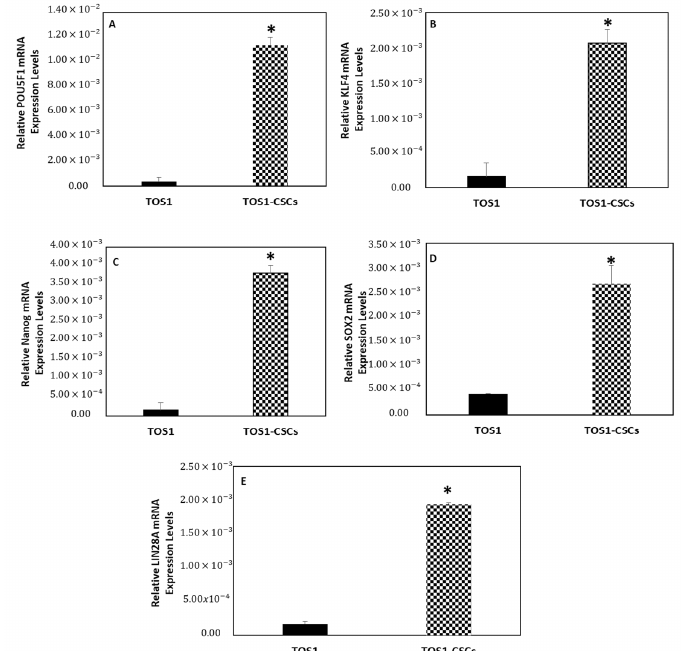
Figure 11. Expression levels of ESC gene markers. The relative POU5F1 ( A ), KLF4 ( B ), Nanog ( C ), SOX2 ( D ) and LIN28A ( E ) mRNA expression levels in TOS1-CSC cell line was determined by RT-